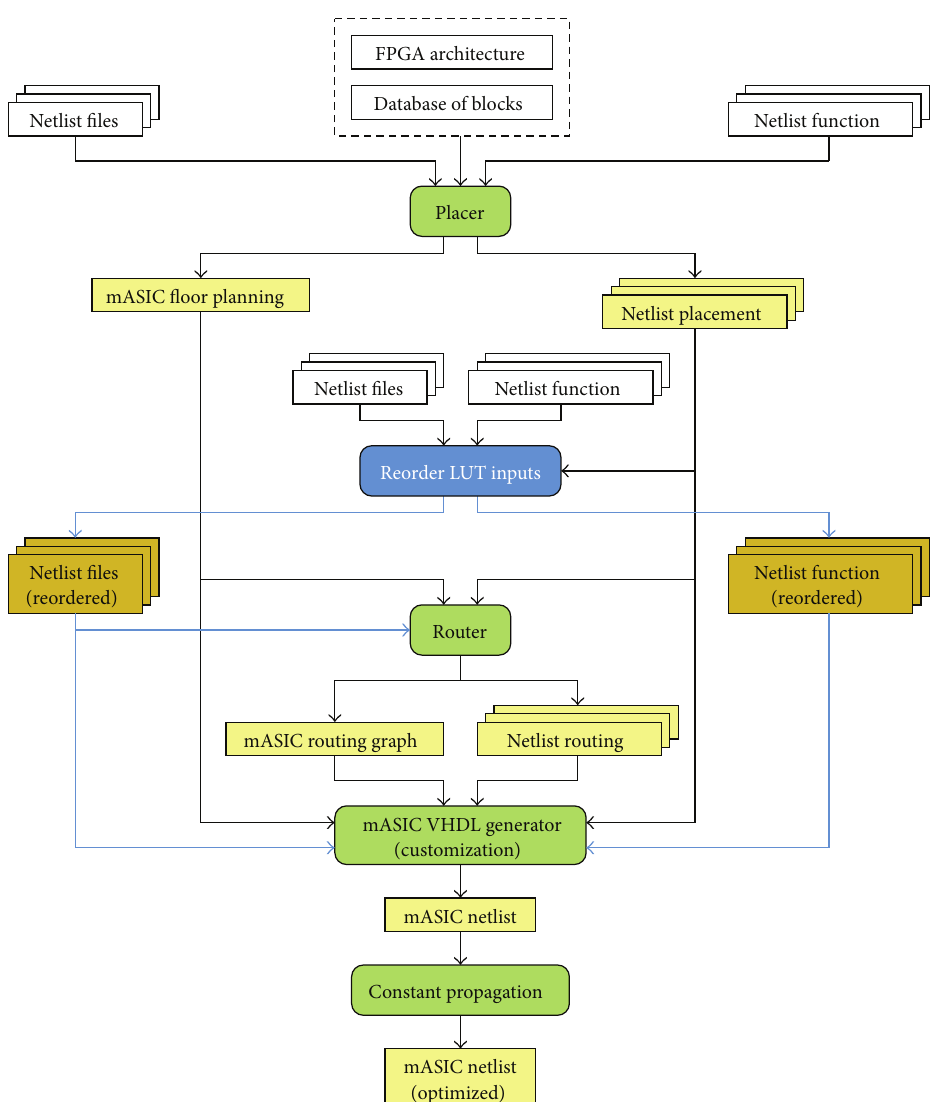
Figure 13: mASIC generation with LUT